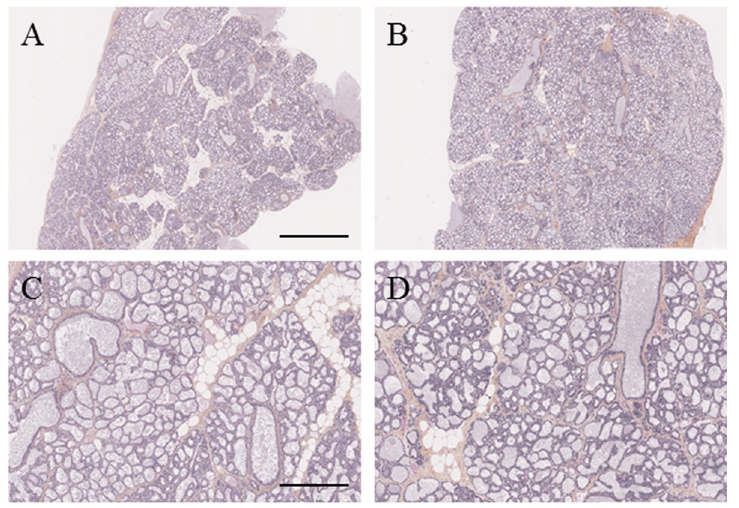
Fig 2. Histological sections of mammary gland from C and DE rabbits at Day 28 of pregnancy. Hematoxylin and eosin staining of 5 μ m cryosections of mammary glands from C (A and C) and DE-exposed (B and D) rabbits were observed at different magnifications. Representative nanozoomer scans were observed at low magnification (A and B: the scale bar represents 2 mm) and higher magnification (C and D: the scale bars represent 250 μ